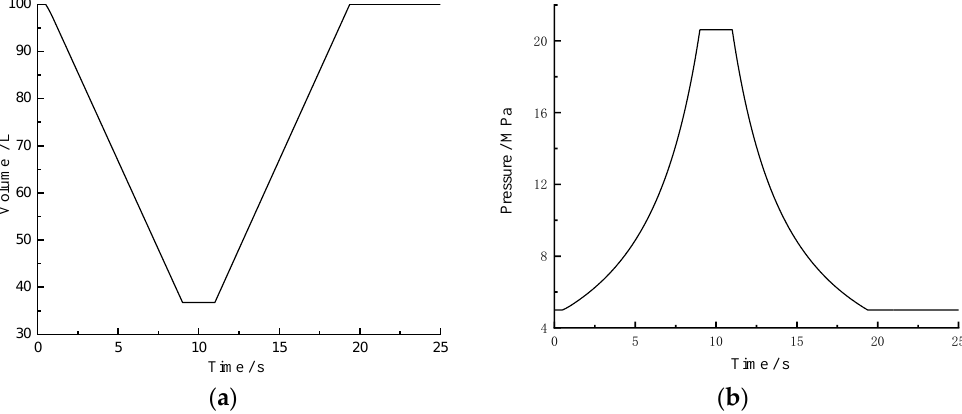
Figure 4. Volume and pressure change of the proposed system when winch lifting and descending. ( a ) Accumulator volume change; ( b ) Accumulator pressure change.